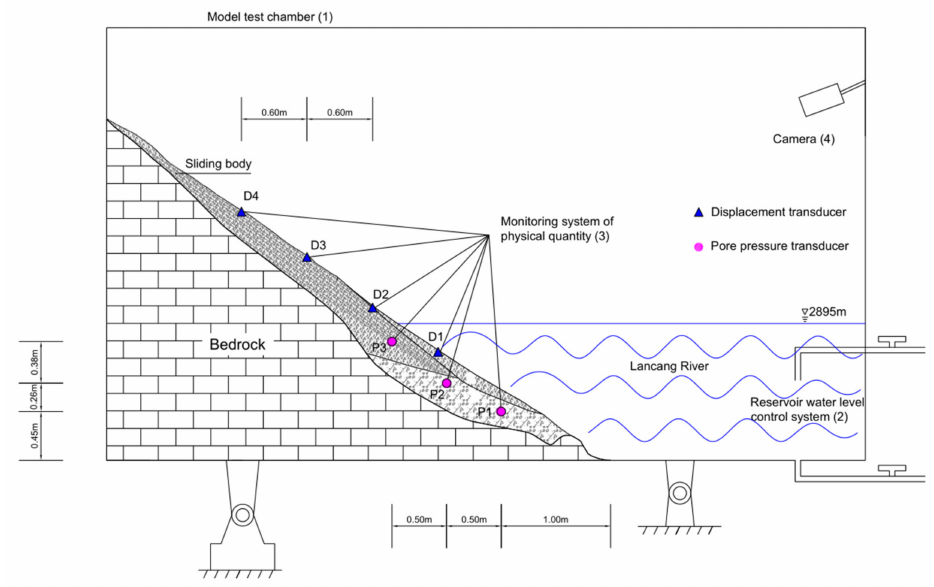
Figure 3. Schematic diagram of the landslide test